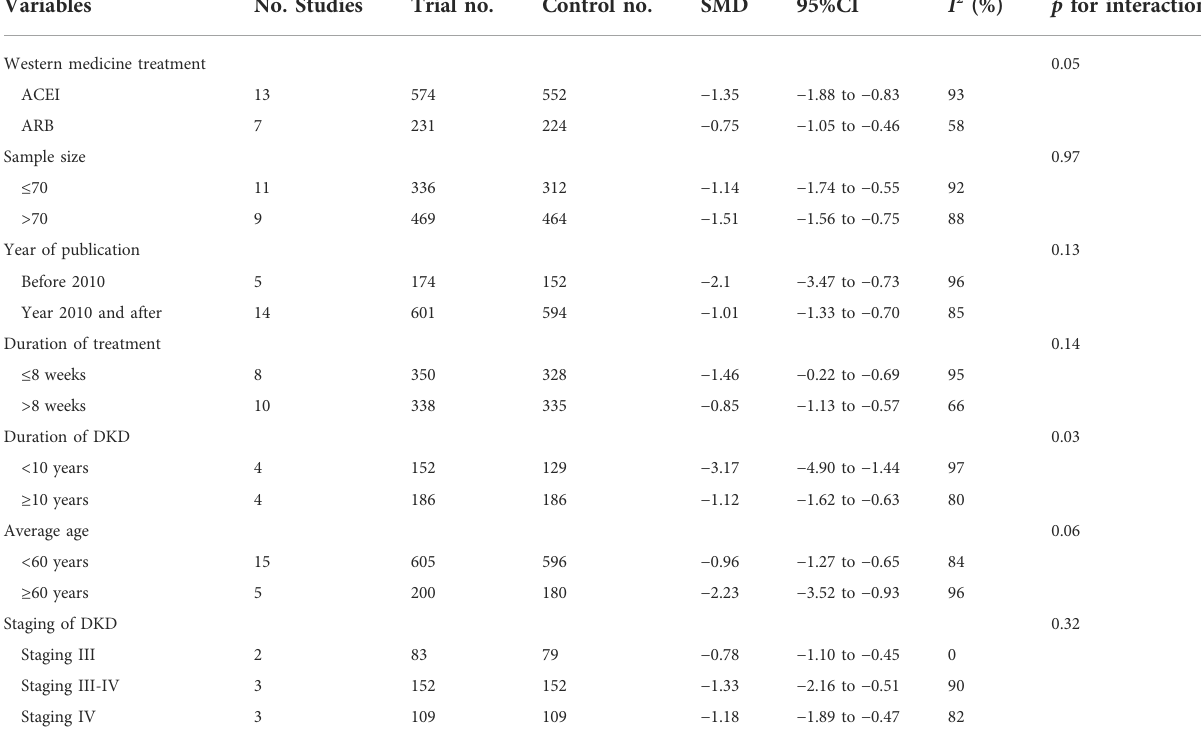
TABLE 4 Subgroup analyses for the effect of 24-h urinary